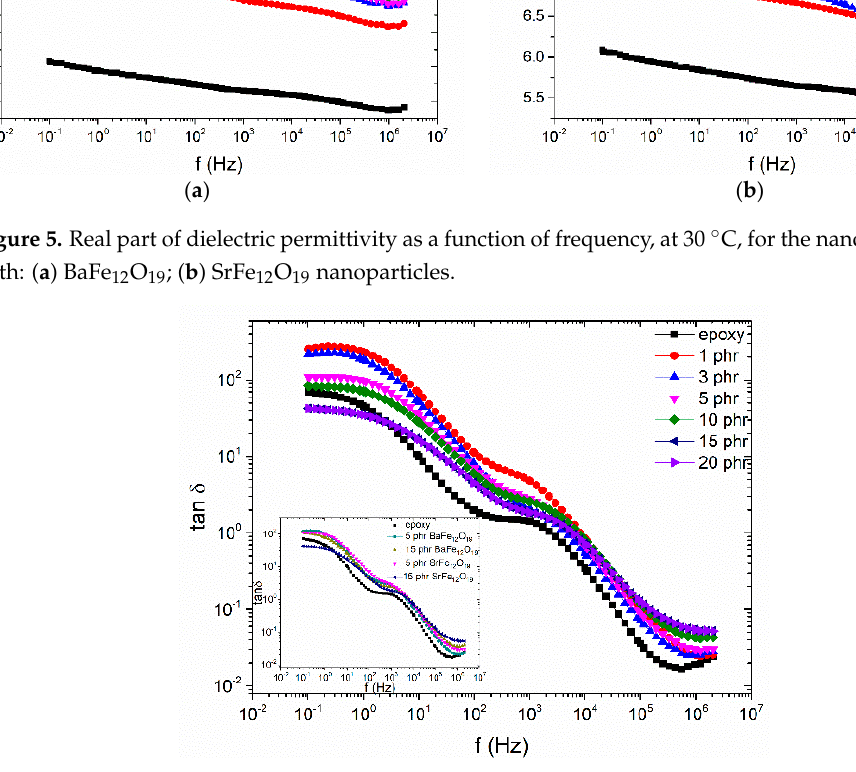
Figure 6. Loss tangent as a function of frequency, for SrFe 12 O 19 examined systems, at 160 °C. Inset depicts the comparative loss tangent spectra, as a function of frequency, at 160 °C for the 5 phr and 15 phr filler content of SrFe 12 O 19 and BaFe 12 O 19 systems.